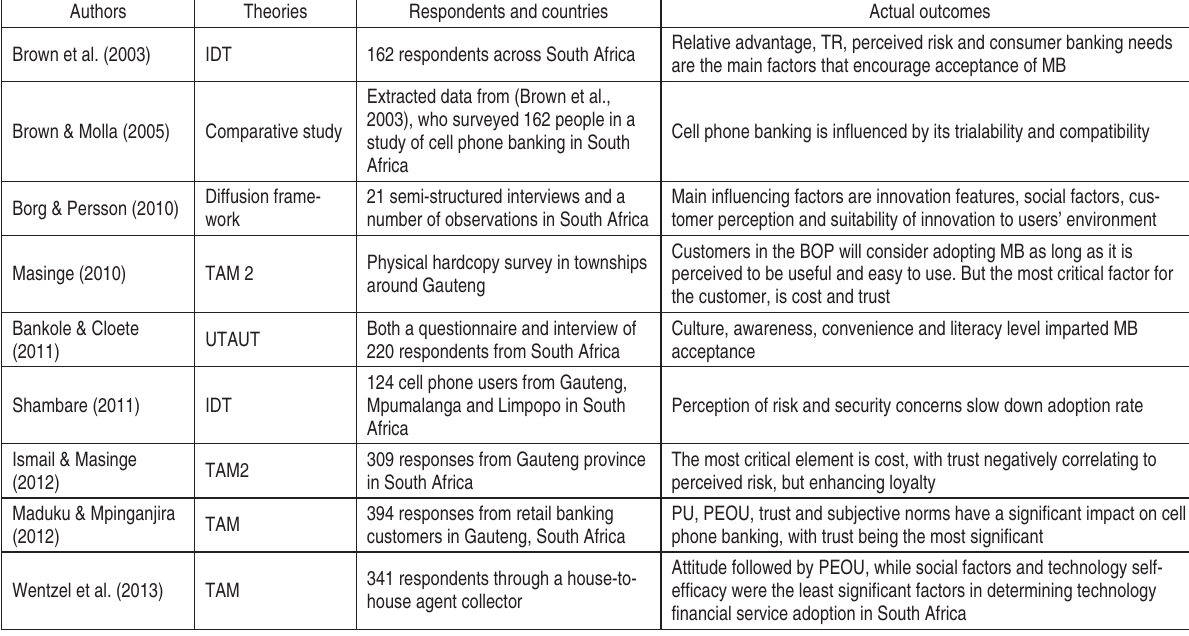
Table 1. Closely related study of mobile banking continuance (MB) Intention in South